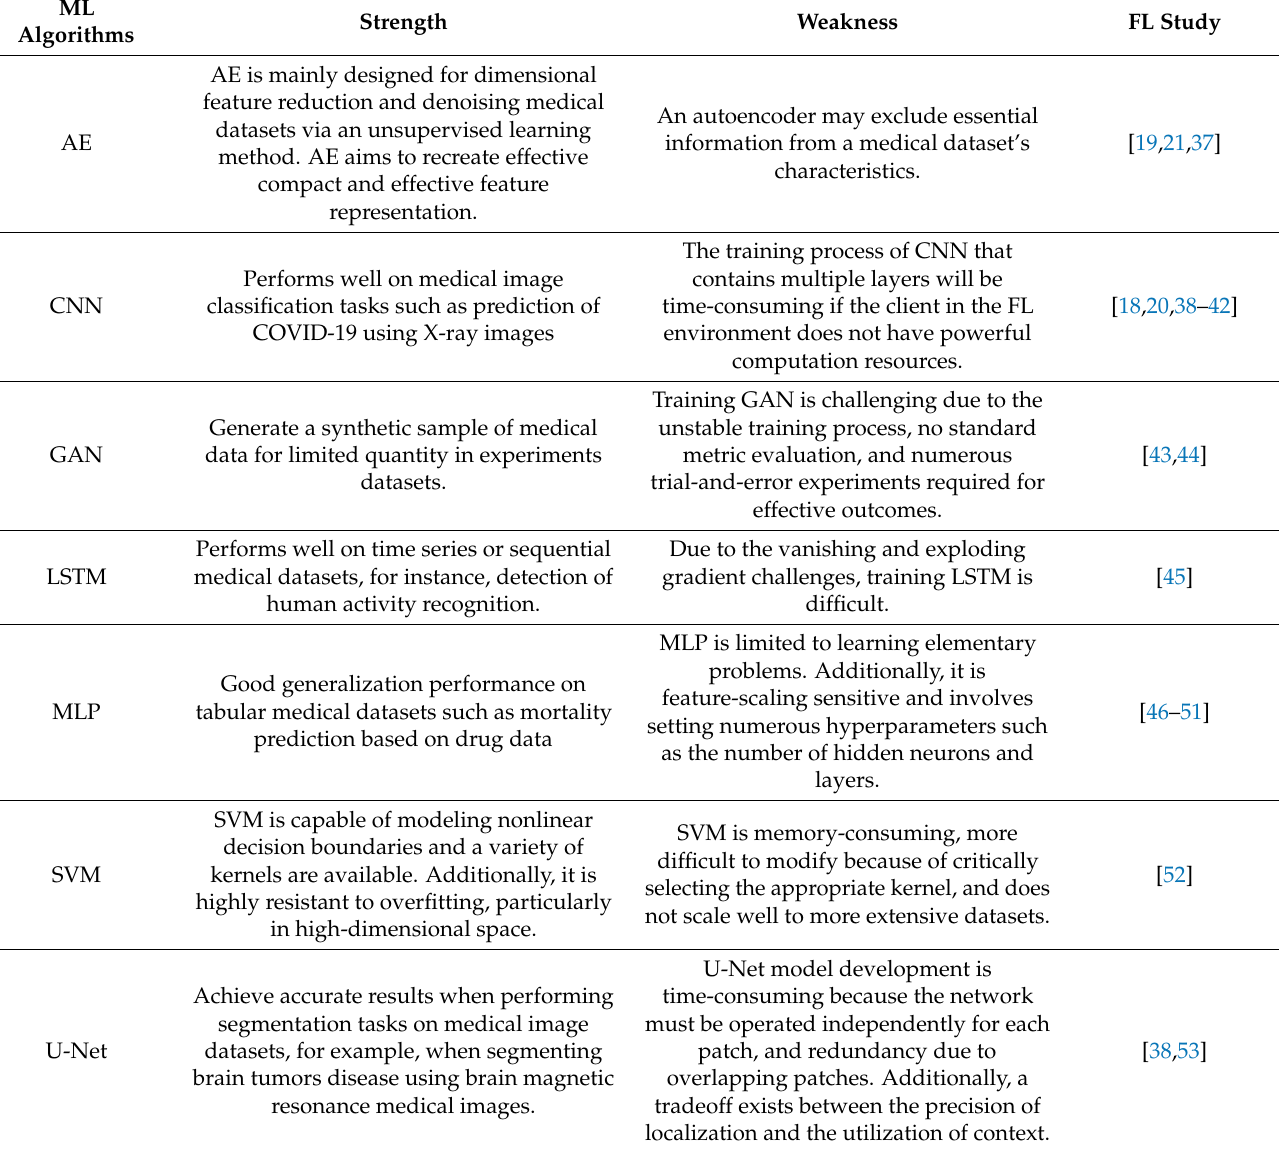
Table 1. Summary of machine learning algorithms performing on federated learning, along with strengths and weaknesses. ML